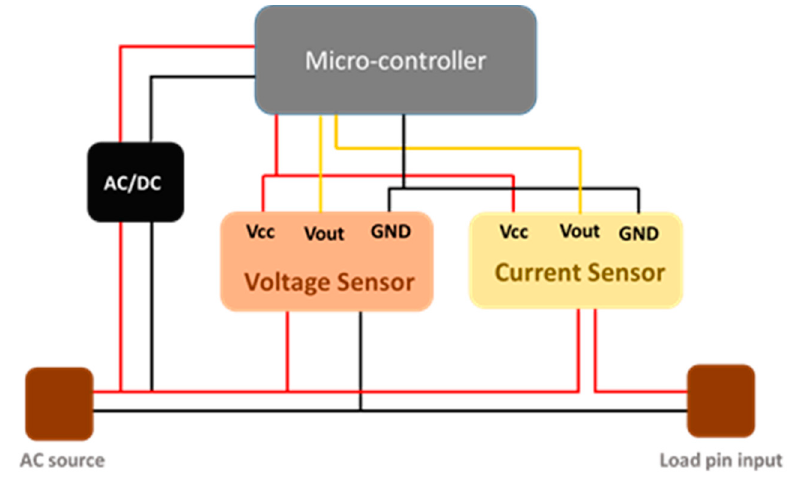
Figure 5. The block diagram of the power meter .